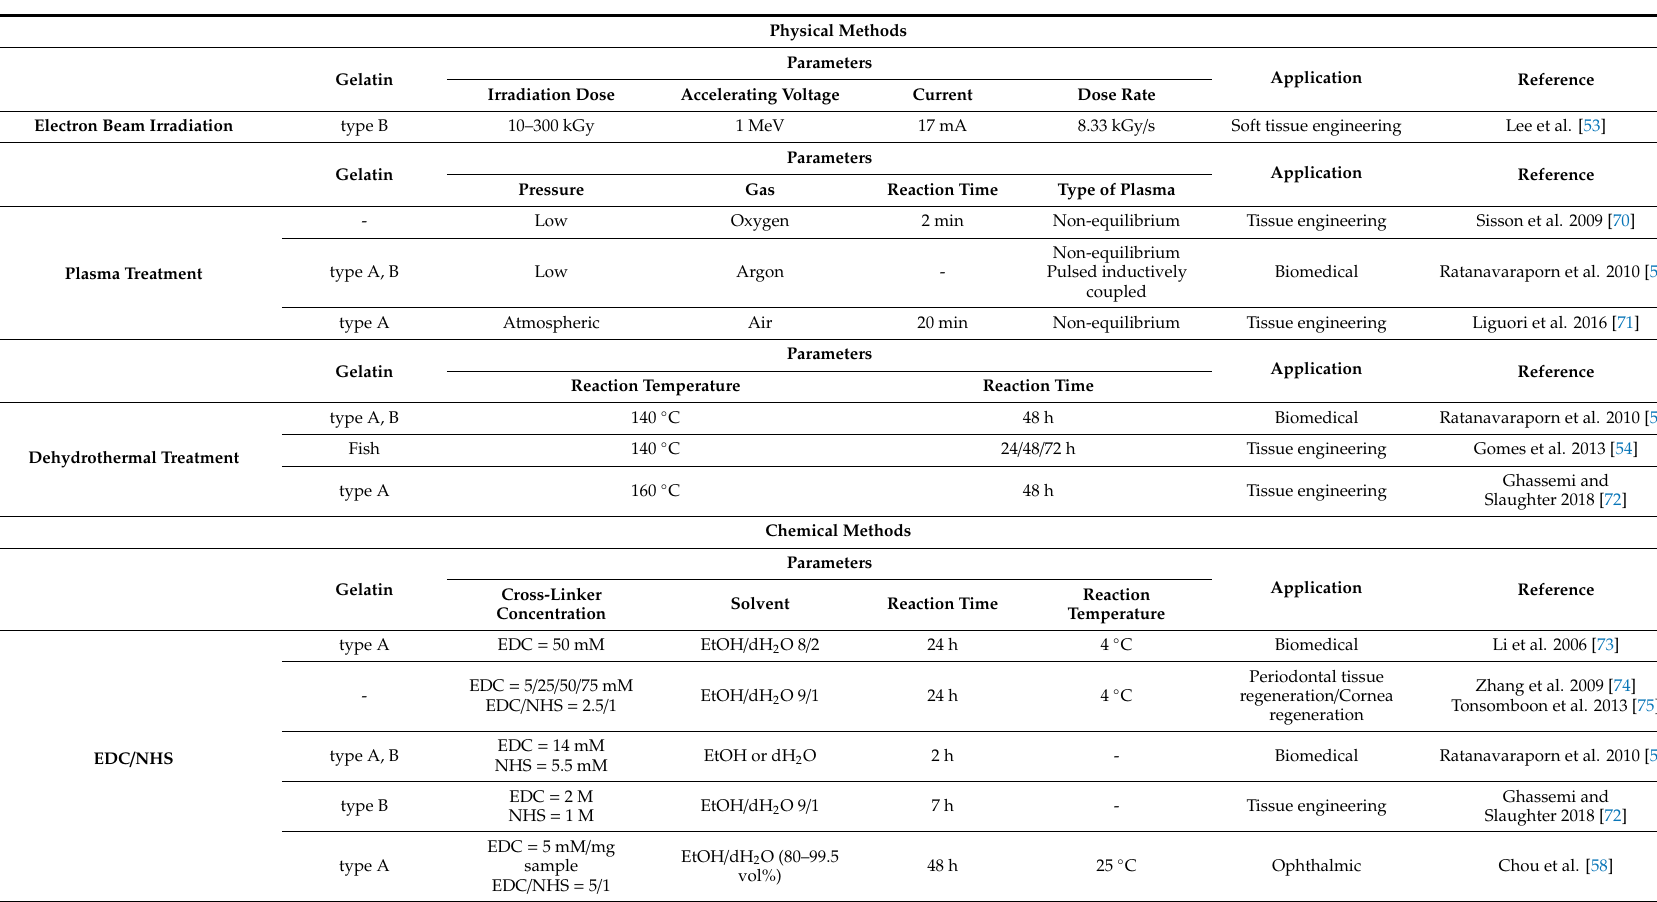
Table 2. Cross-linking strategies employed in the stabilization of electrospun gelatin nanofibers. Strategies are divided by physical and chemical methods. The type of gelatin and the main parameters involved in the cross-linking process are reported, as well as the final aim of the